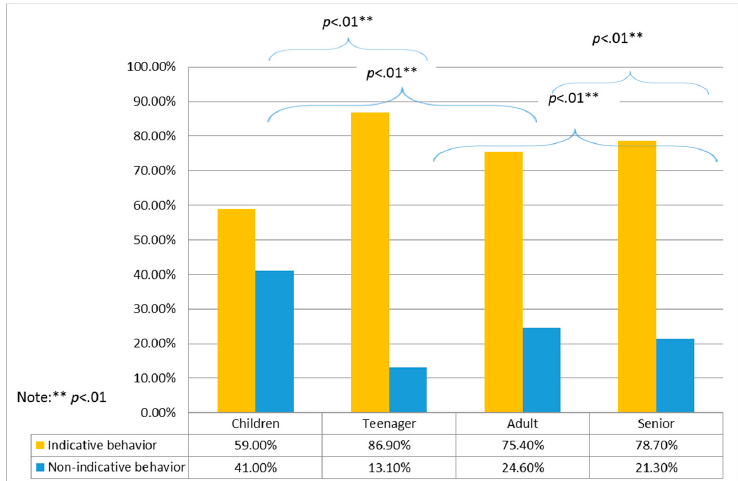
Figure 4. Post-hoc test results of user groups and indicative behaviors for the ski machine.